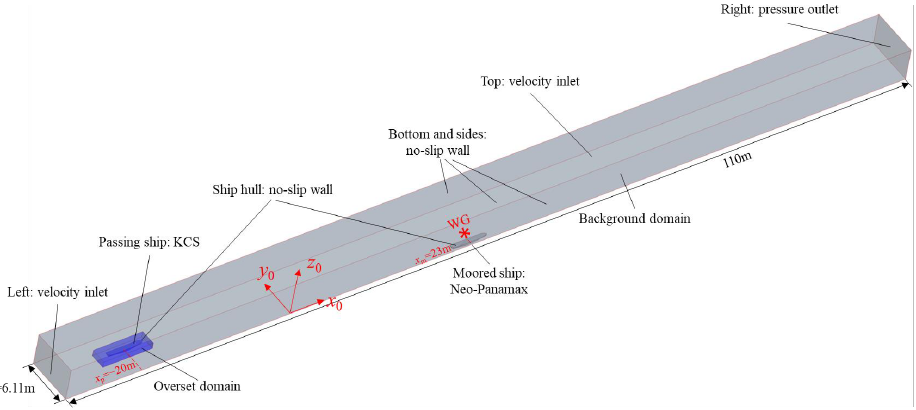
Figure 3. Computational domain and boundary conditions.